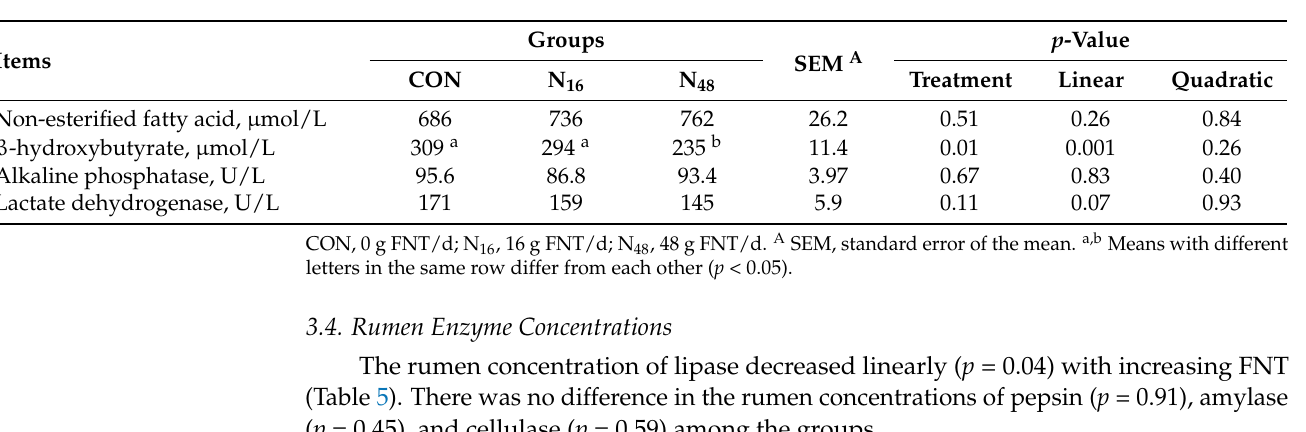
Table 4. Effects of the fruit of Nitraria tangutorum (FNT) supplement on serum metabolites in Hu rams.